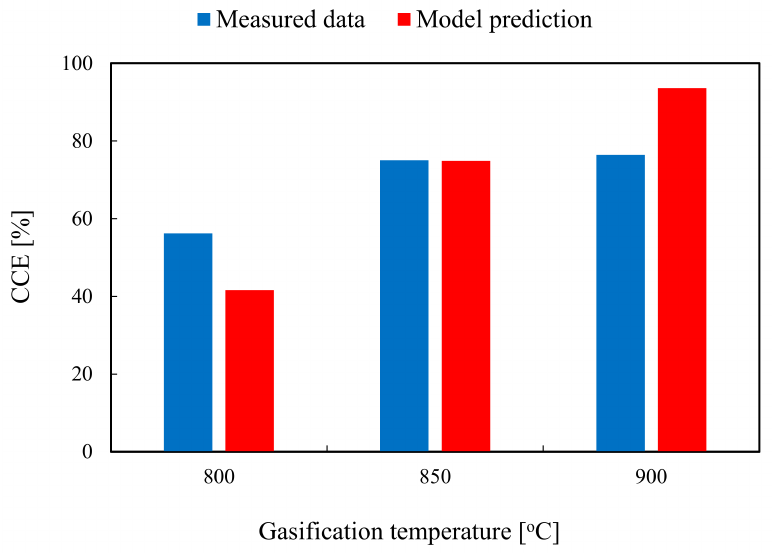
Figure 6. Effect of gasification temperature on carbon conversion efficiency.